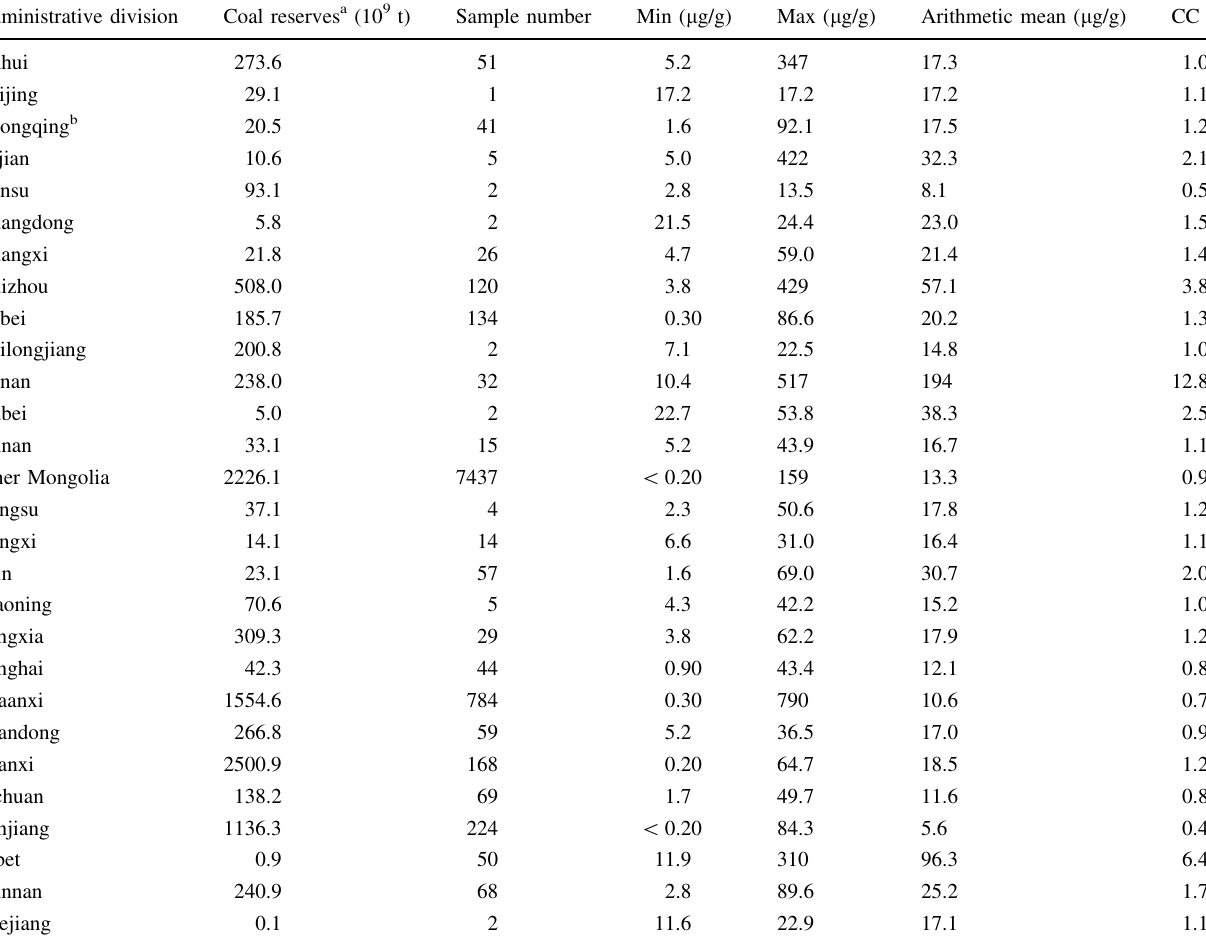
Table 5 Coal reserves and lead contents in coals for different provinces in